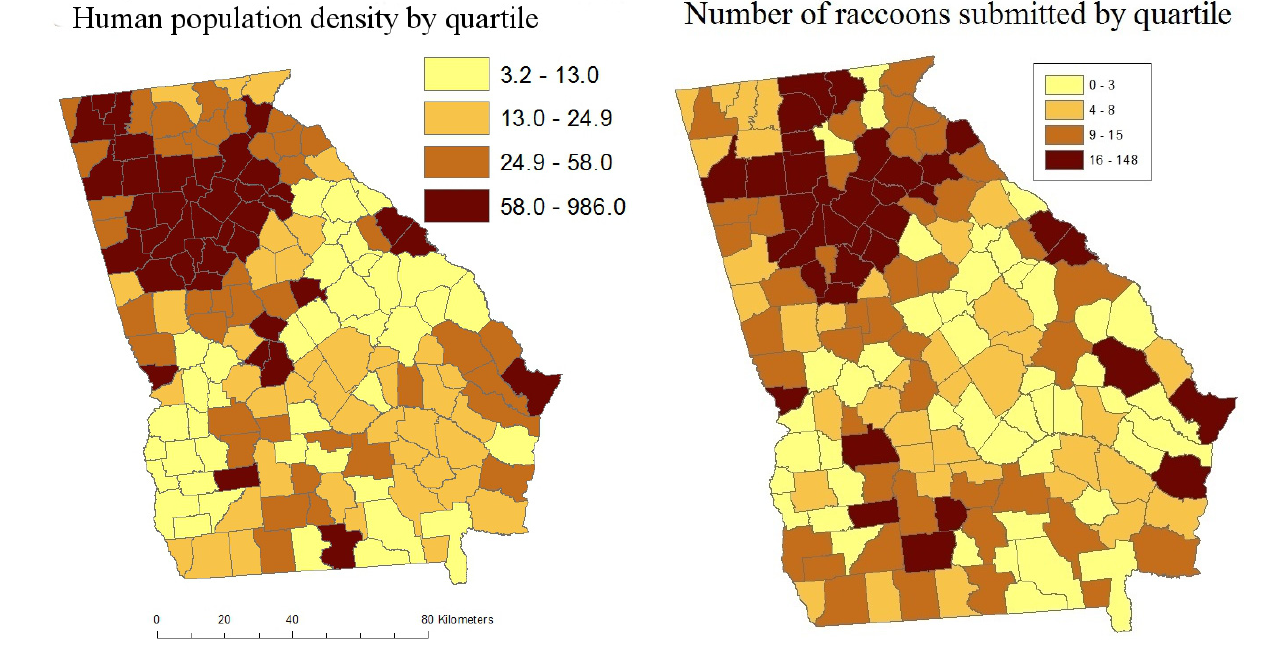
Figure 3. The population densities of 159 Georgia counties by quartile from the 2010 census as compared to the number of raccoons submitted per county for rabies testing by quartile from 2006–2010.